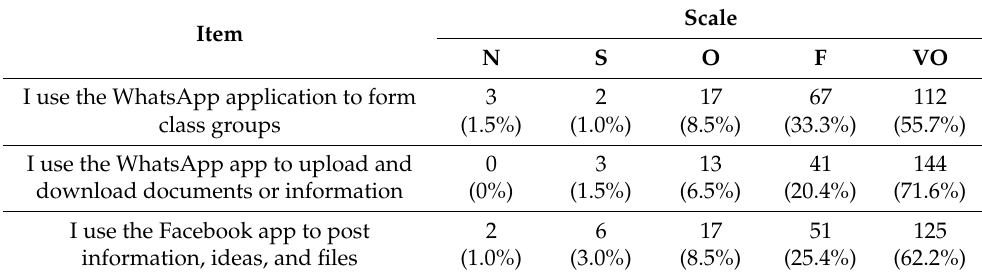
Table 6. Percentage of Application Use in Learning. Item